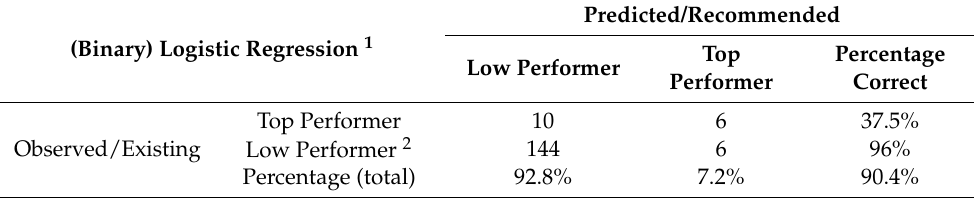
Table 5. Sensitivity and specificity of the (binary) logistic regression analysis.